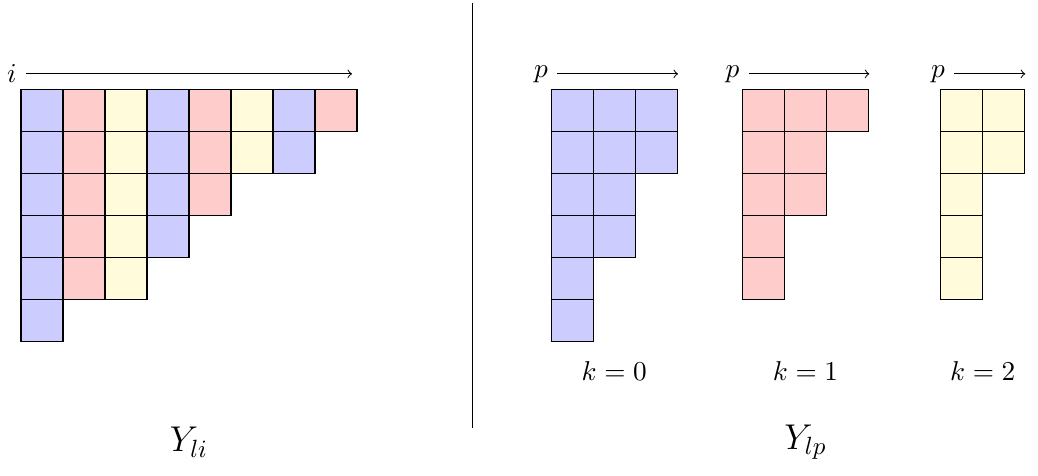
Figure 1 . Fractionalization and recombination of the Young diagrams representing singular in- stantons for n =